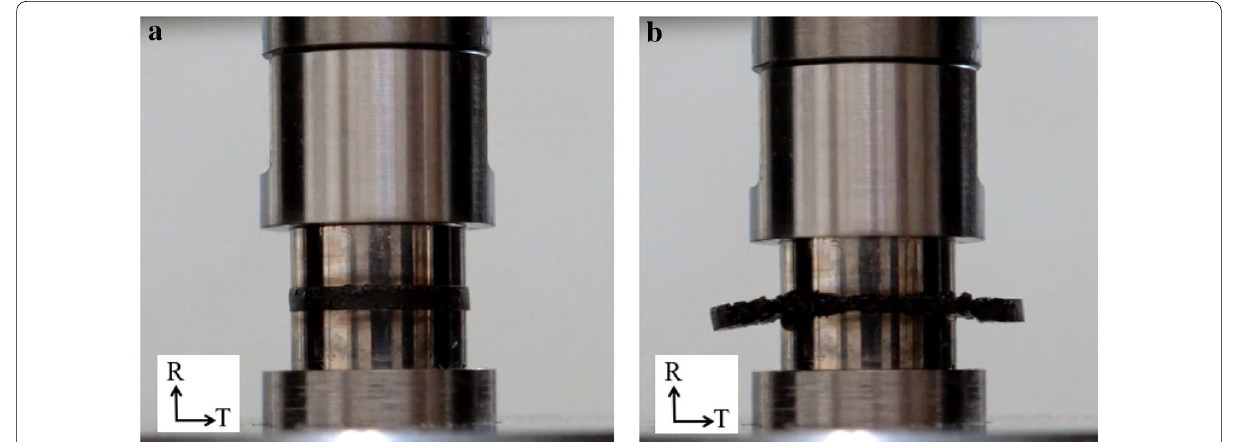
Fig. 5 Specimen in the free compression test: a before and b after compression up to 113 MPa compressive stress